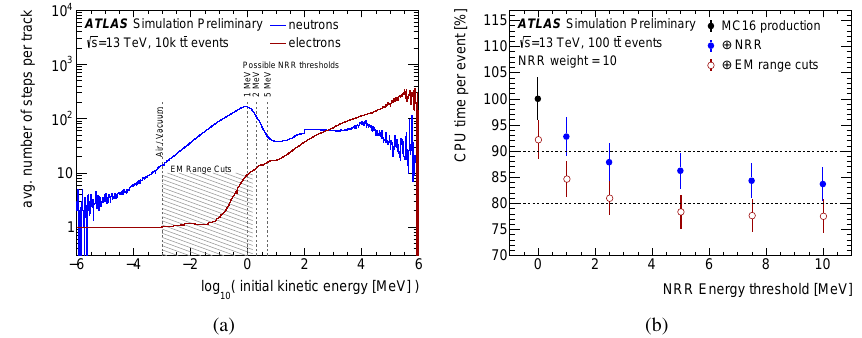
Figure 3: (a) Average number of Geant4 steps per track as a function of the initial kinetic energy in the default setup (MC16 production). Vertical lines indicate the potential energy threshold for the NRR algorithm and the hatched box indicates where Range Cuts have the largest e ff ect. (b) CPU time per event for various thresholds of the NRR algorithm with respect to the average MC16 value (black dot) with or without the EM range cuts. Error bars indicate the RMS of CPU time for the simulated events. Figures taken from ref.